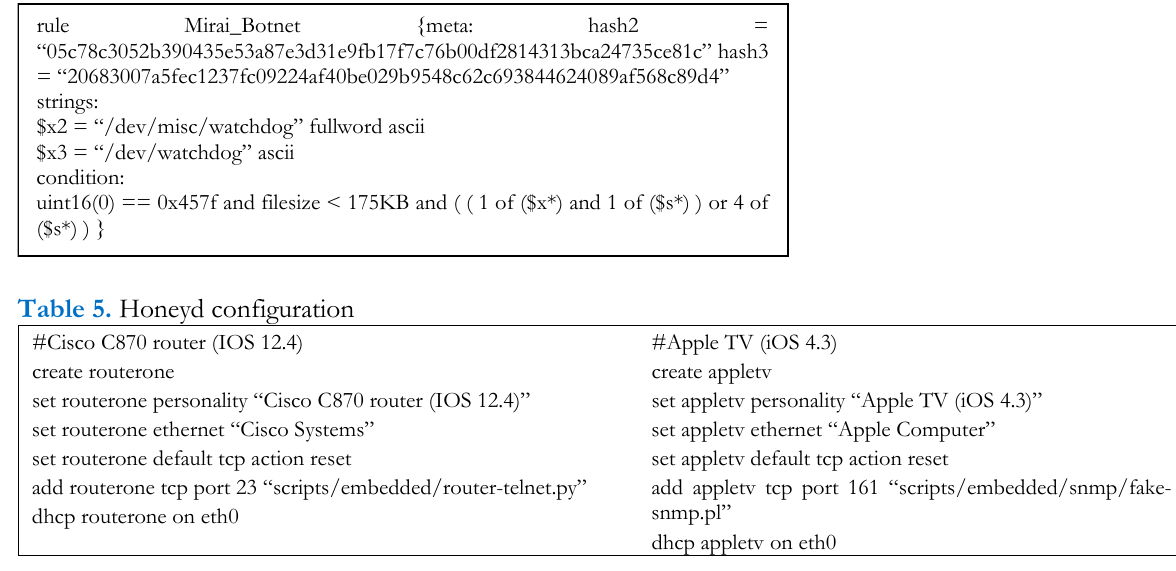
Table 4. Custom Yara rule for Mirai malware